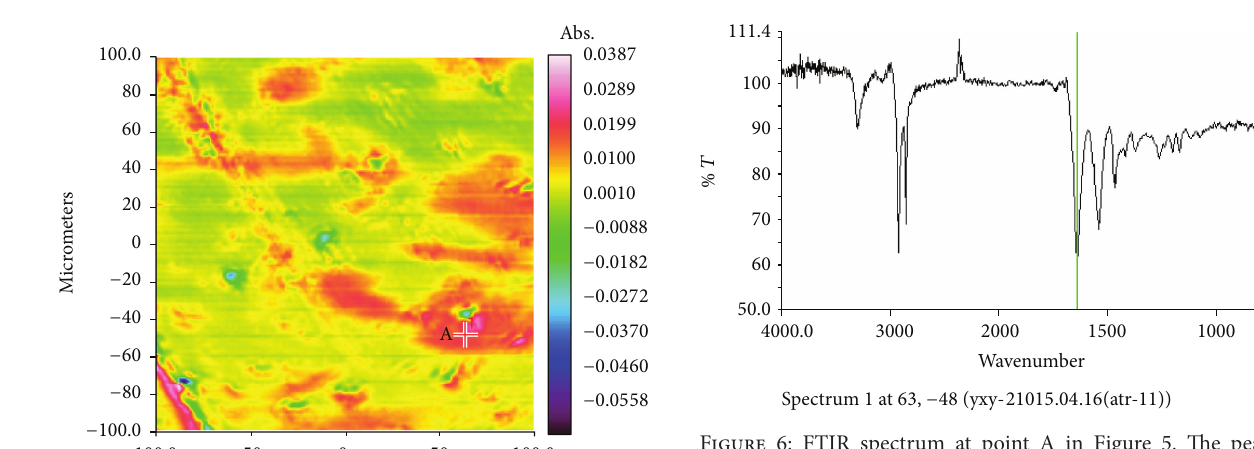
Figure 6: FTIR spectrum at point A in Figure 5. The peak at 1637.8 cm −1 is